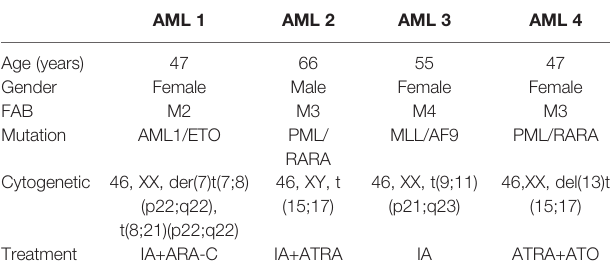
TABLE 1 | Clinical features of four AML